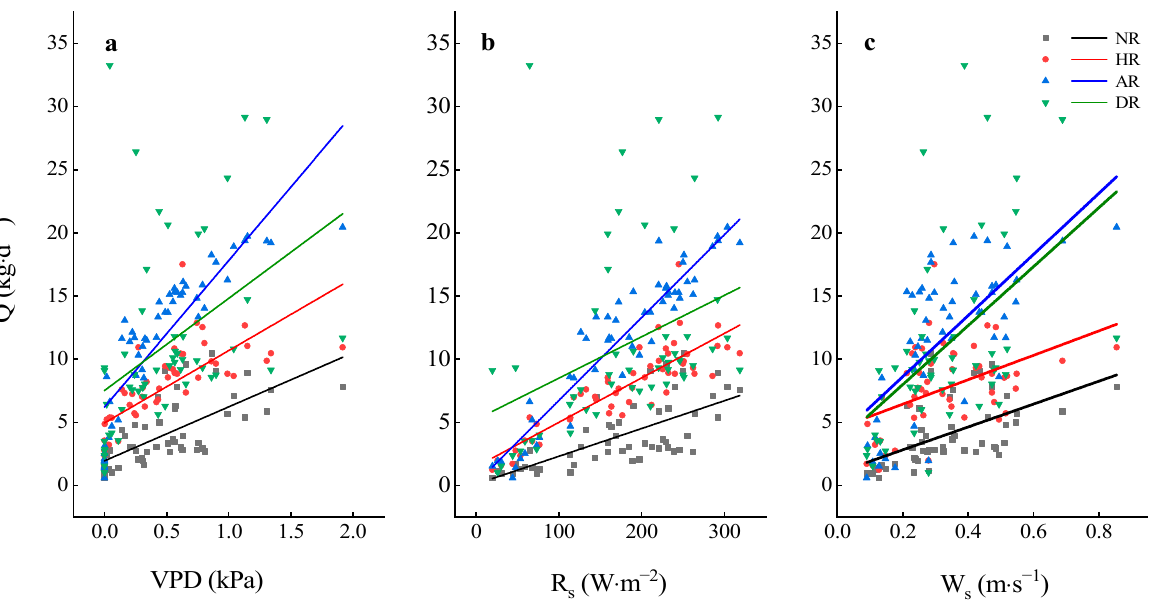
Figure 9. Linear regression showing the relationship between Q and environmental factors impacting the growth of P. orientalis during the observation period. The regresssion line of four treatments area are NR treatment (NR), HR treatment (HR), AR treatment (AR), and DR treatment (DR). ( a ) Vapor pressure deficit (VPD). ( b) Solar radiation (R S ). ( c ) Wind speed (W S ).